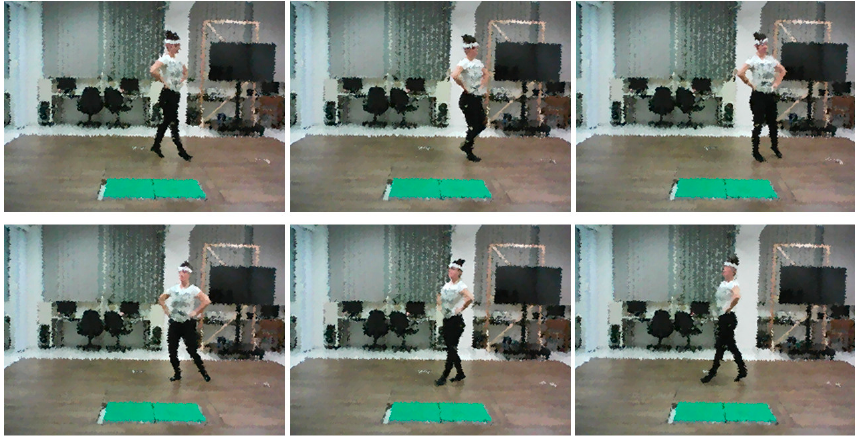
Figure 2. Illustration of the Syrtos dance.